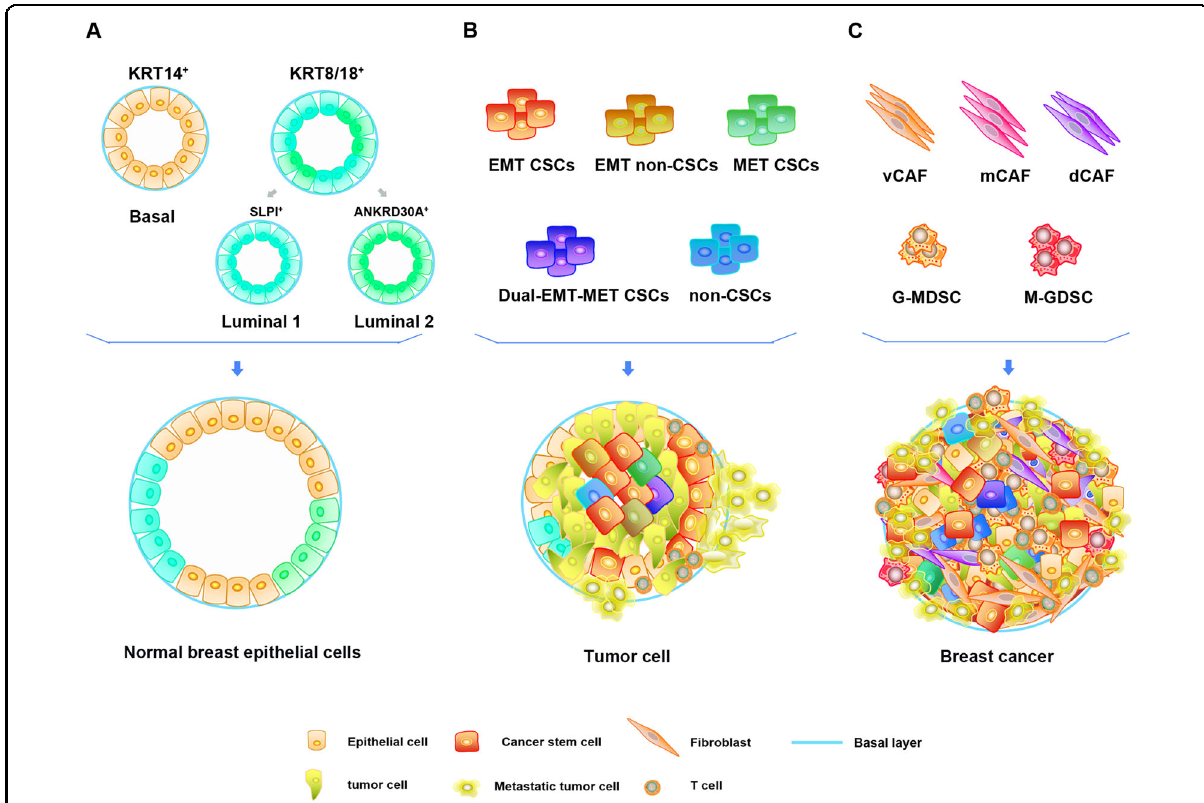
Fig. 1 Schematic illustration of the heterogeneity of normal breast epithelium, cancer stem cells, and stromal cells in the tumor microenvironment. A The heterogeneity of normal breast epithelial cells. KRT14 and KRT8/18 are genetic markers of basal and luminal breast epithelium, respectively. The luminal epithelial cells are composed of luminal 1 (SLPI + ) and luminal 2 (ANKRD30A + ). B According to EMT-related genes, cancer stem cells are divided into EMT CSCs, MET CSCs, dual-EMT-MET CSCs, EMT non-CSCs, and non-CSCs. C The heterogeneity of tumor- associated fi broblasts and MDSCs in the tumor microenvironment. The tumor-associated fi broblasts at least include the subpopulations of vascular CAFs (vCAFs), matrix CAFs (mCAFs), and developmental CAFs (dCAFs), whereas the MDSCs are identi fi ed to be derived from neutrophils (G-MDSCs) and mononuclear cells